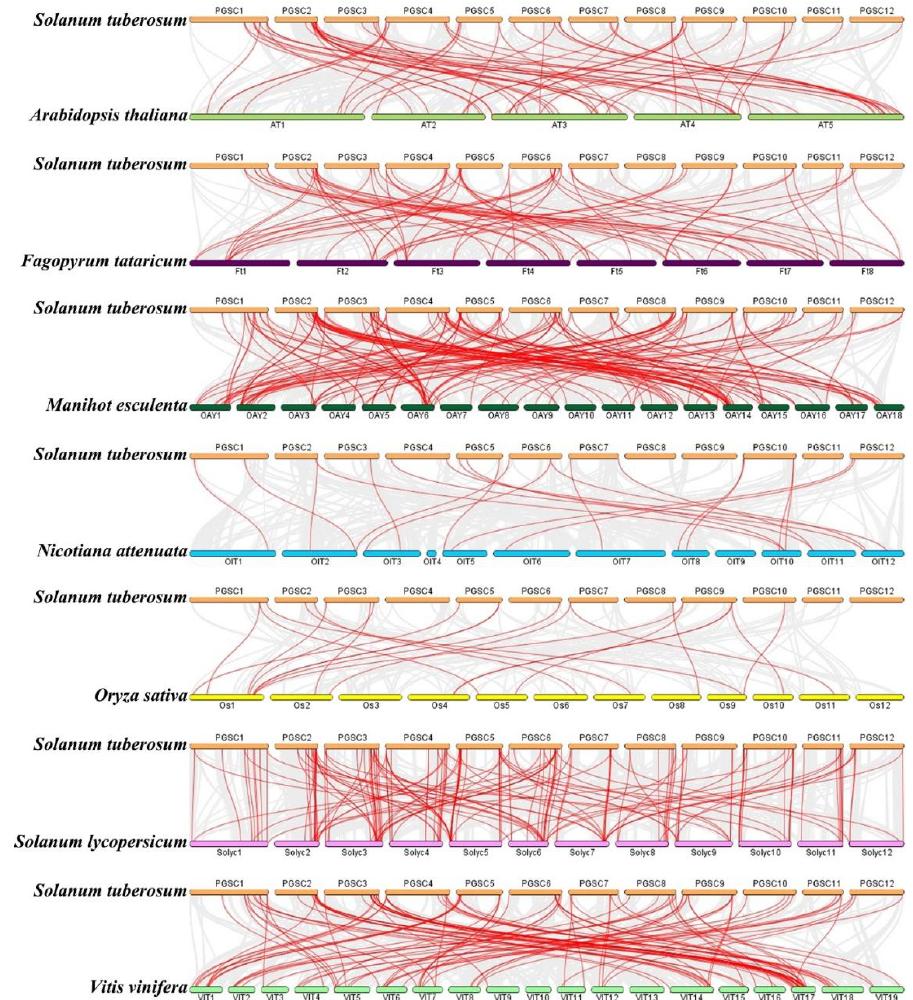
Figure 6. Synteny analyses between the MYB genes of potato and seven representative plant species. Gray lines in the background indicate collinear blocks within potato and other plant genomes, while red lines highlight syntenic MYB gene pairs.